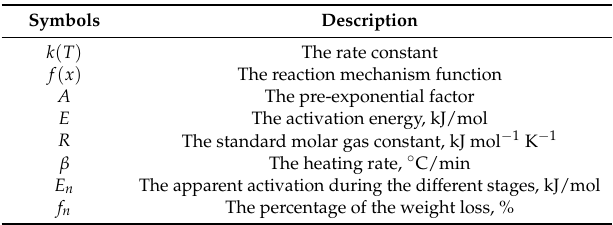
Table 5. Nomenclature report for